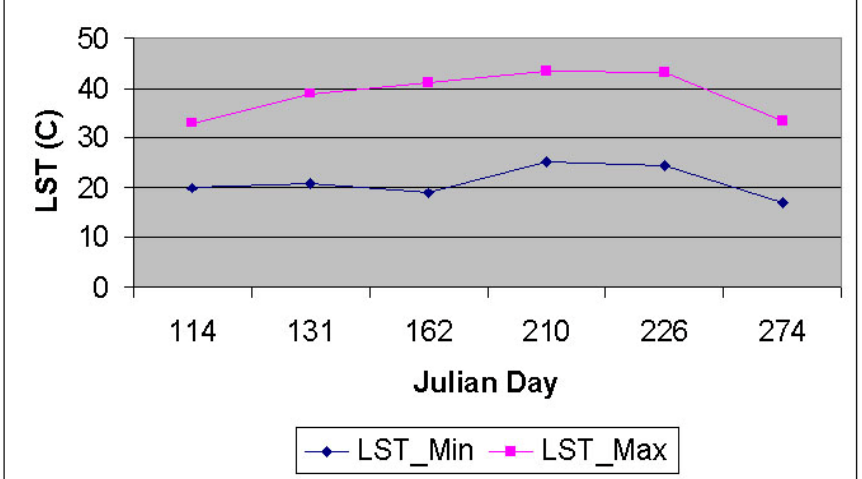
Figure 9. Minimum (cold) and maximum (hot) LST values from six Landsat images.